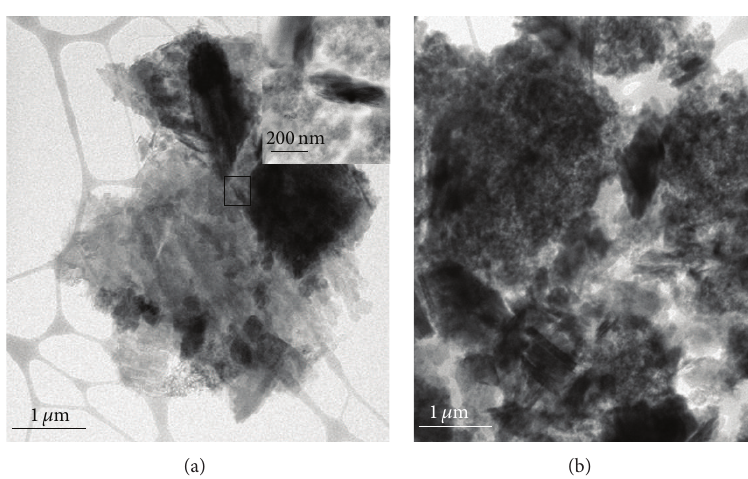
Figure 4: TEM images of enriched zeolites with SiO 2(